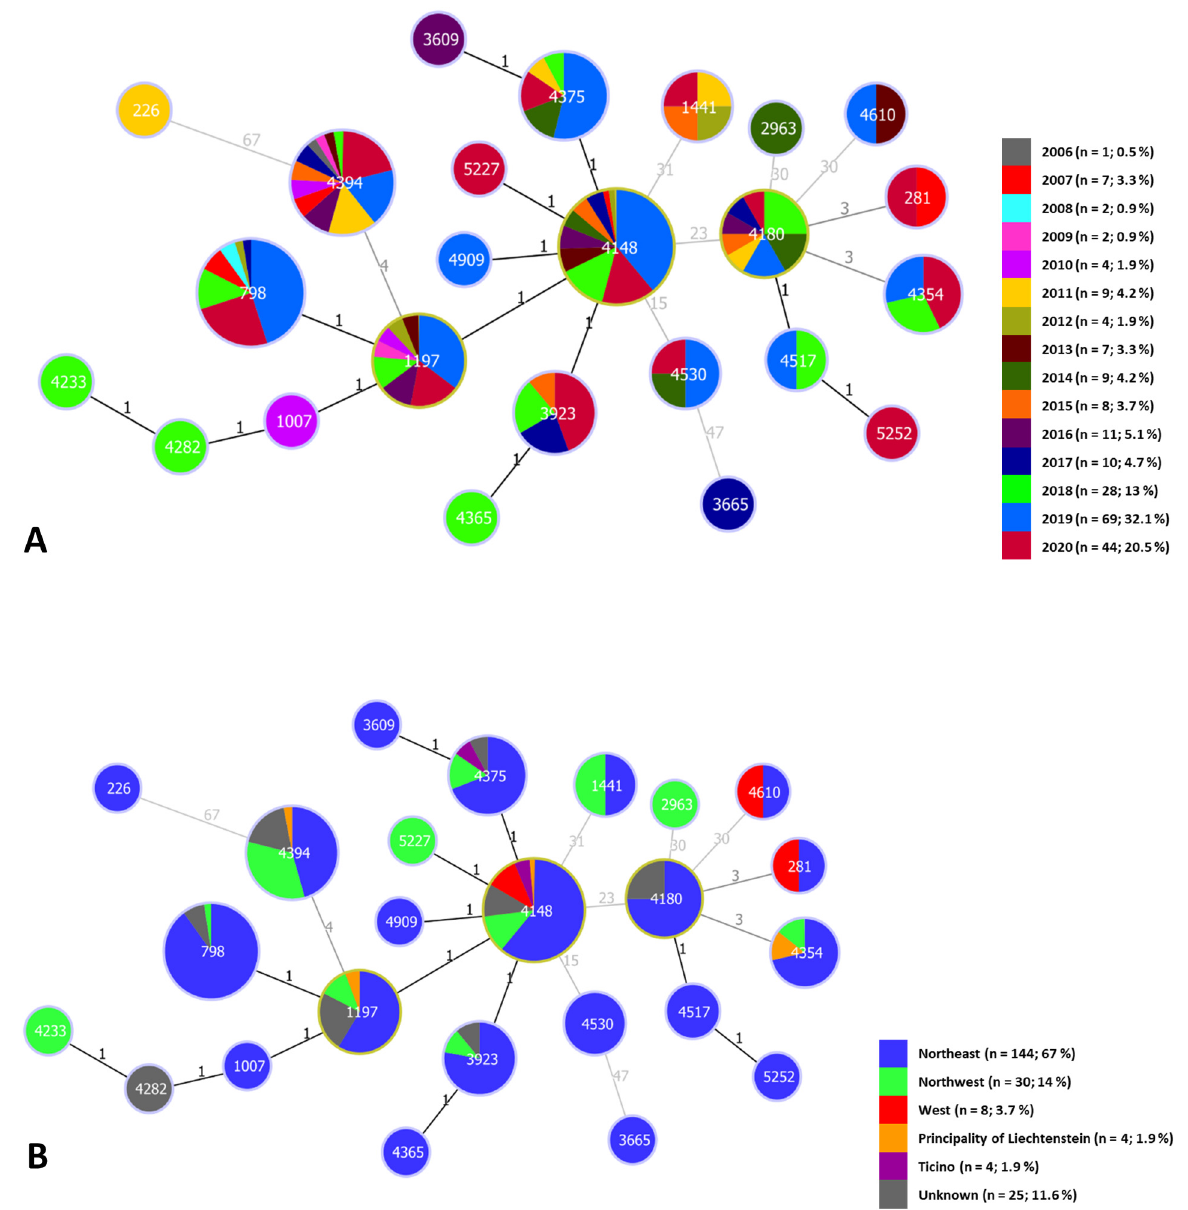
Figure 3. MLSA-based minimal spanning tree of 215 C. pseudotuberculosis field isolates. Two diagrams were calculated using the goeBURST full MLST algorithm in PHYLOViZ 2.0. Each circle represents one ST, and the size represents the number of isolates in each ST. Exact numbers of isolates per ST are given in Figure 2. Numbers within the nodes indicate a representative isolate in this cluster. Numbers on lines connecting STs indicate locus variants between nodes. Black lines indicate single-locus variants, and gray lines represent multilocus variants. ( A ) The isolates are color-coded according to the year of isolation, as given in the key on the right. The pie chart depicts the isolates from each year as fractions of the total number of isolates. ( B ) The isolates are color-coded according to the region of isolation, as given in the key on the